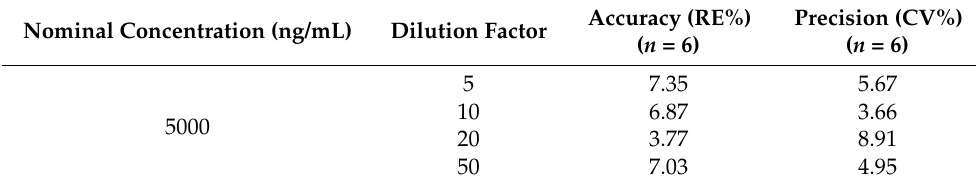
Table 5. Dilution integrity accuracy and precision of OJT007 in rat